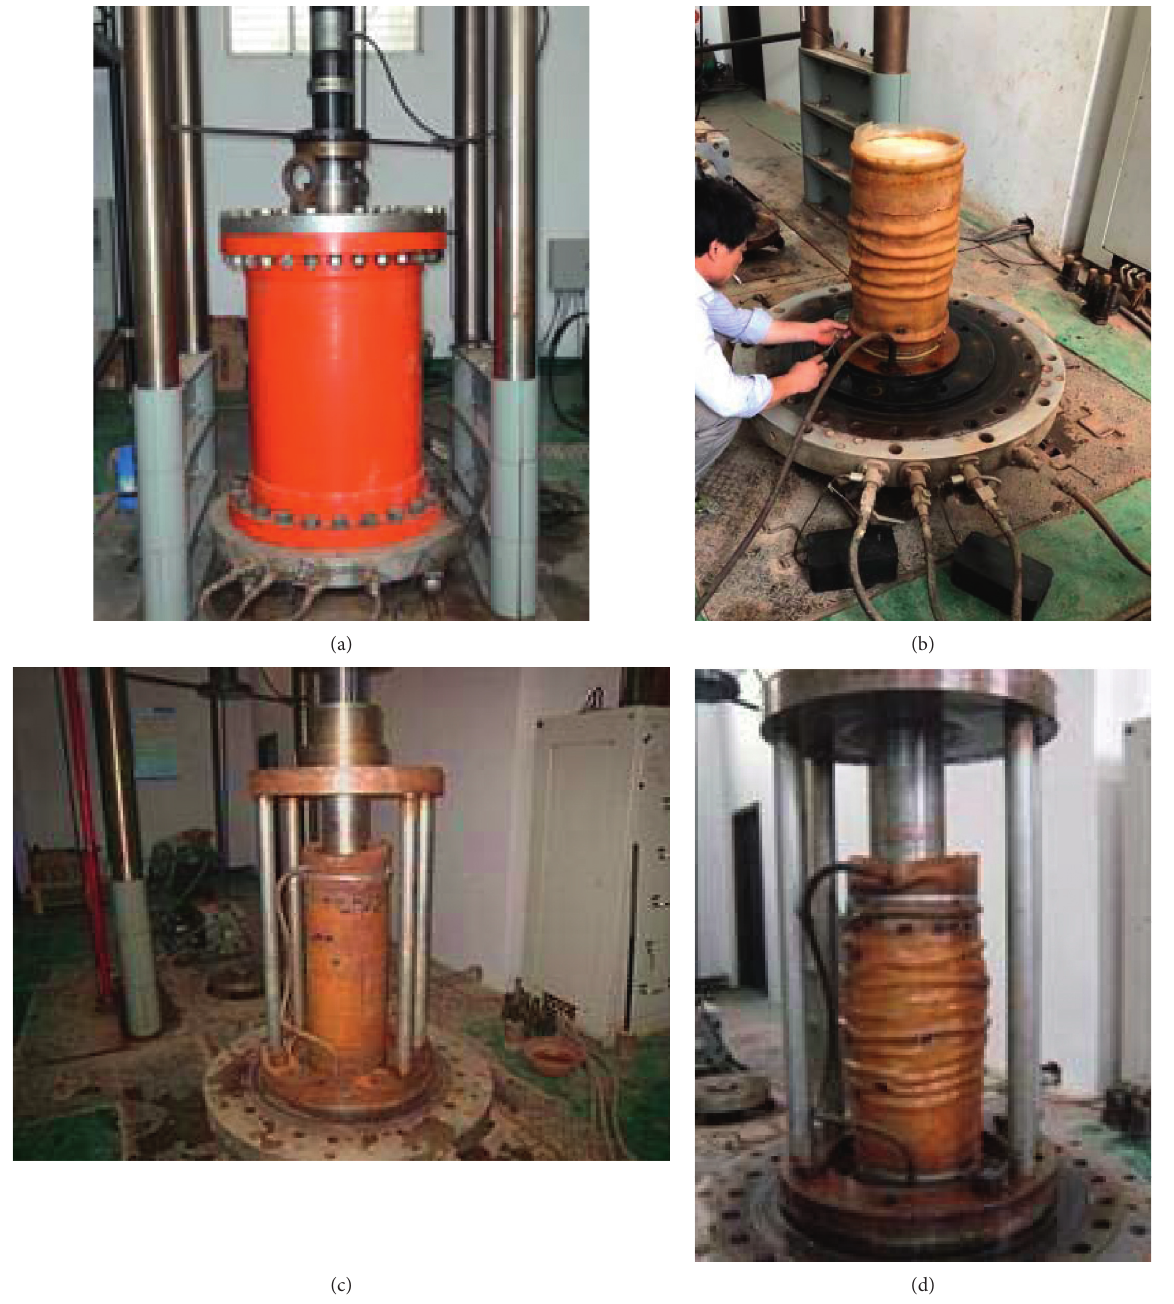
Figure 4: Large-scale triaxial test of coarse-grained materials: (a) laboratory apparatus; (b) installation sample; (c) before the test; (d) after the